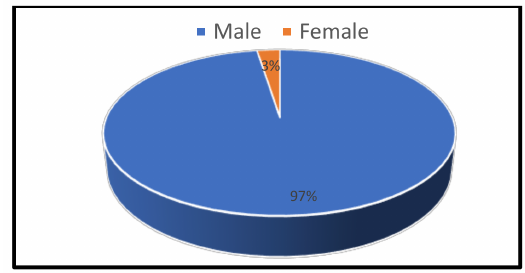
Figure 10. Gender of the vegetable seed farmers.